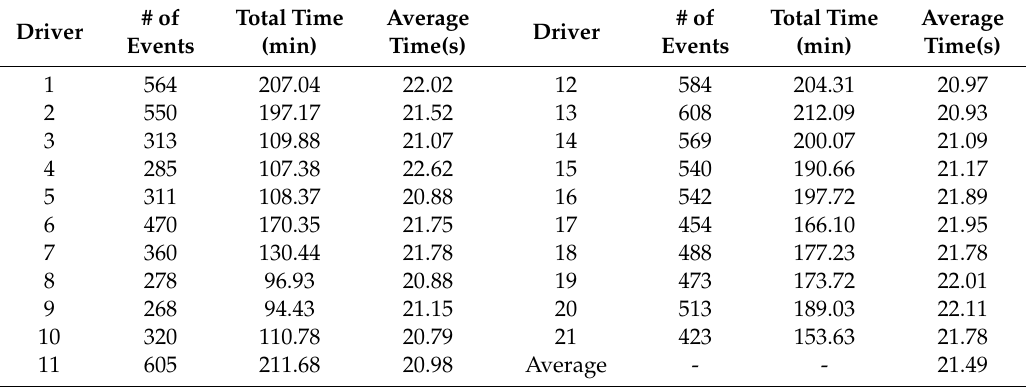
Table 1. Statistical results of extracted driving data for all drivers.